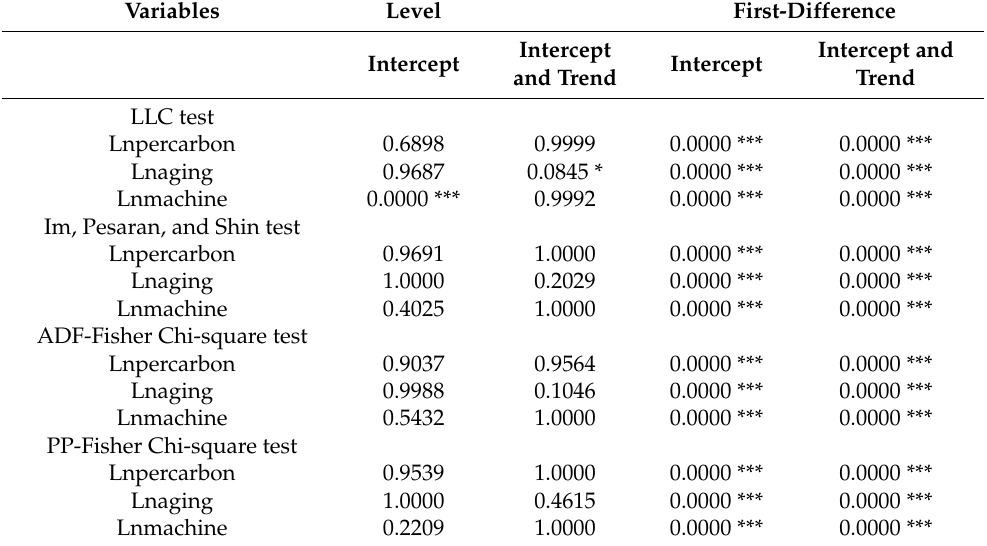
Table 5. Panel unit root tests results.